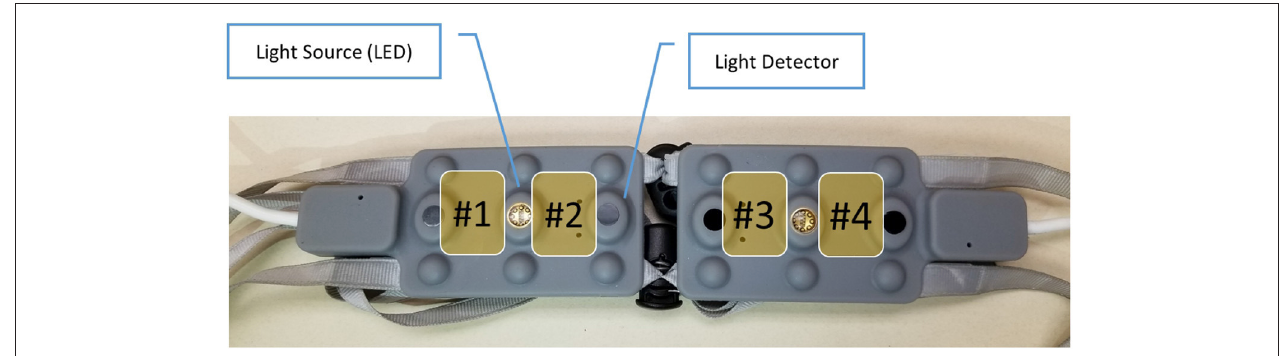
FIGURE 7 | Miniaturized and wireless fNIR Device ® Model 1200W headband and associated regions of interest (optodes). Optodes are represented in yellow with their associated number.